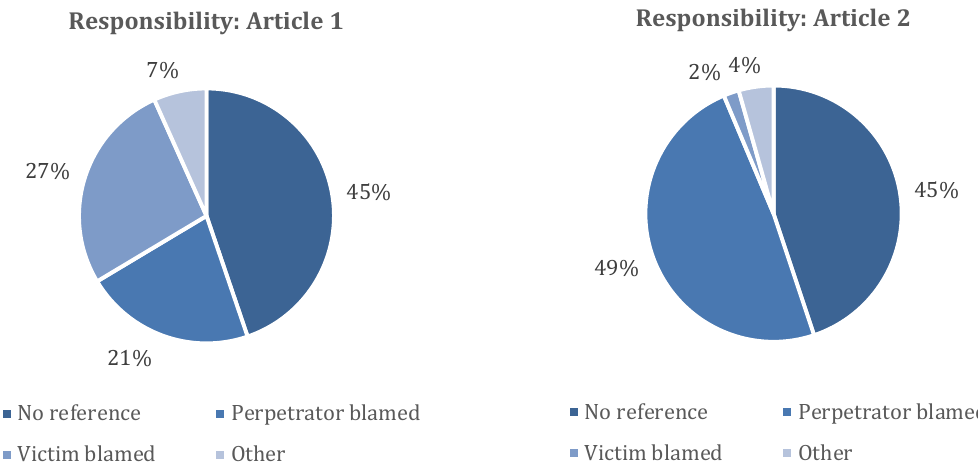
Figure 6: Responsibility assigned for the attack in Articles 1 and 2